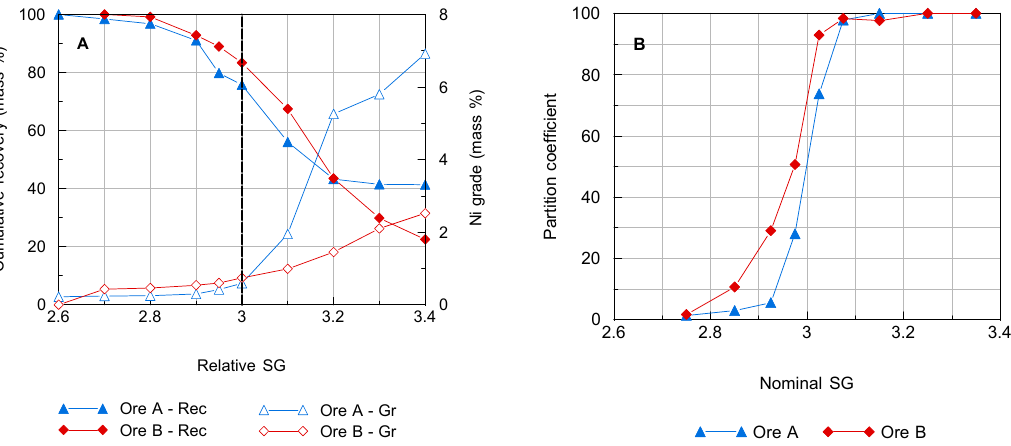
Figure 3. Comparison of grade and recovery curves ( A ) and partition curves ( B ) for ores A and B. The nickel grades and recoveries, as well as mass distribution for the two ore samples, were calculated for different streams of the flowsheet. This includes mass-balanced data from the ROM material to the calculated flotation feed, which is made up of the DMC underflow and the − 1 mm fines that were initially removed (Table 2). The sample of ore A showed a 54% total nickel upgrade from 0.43% in the ROM to 0.66% in the flotation feed, with an 87% nickel recovery to the flotation plant. Calculated results indicate that 44% of the ROM mass was rejected in the DMC overflow, which had a nickel grade of 0.13%. The nickel in the bulk sample of ore B was upgraded by 52%, from 0.28% in the ROM to 0.42% in the flotation feed. Ninety-three per cent of the ROM nickel was recovered to the flotation plant. The mass-balanced data indicated that 39% of the ROM mass was rejected in the DMC overflow. The average nickel grade of the rejected material contained in the overflow stream was 0.05%. Table 2. Mass-balanced mass, grade and recovery information at different points in the flowsheet. Stream